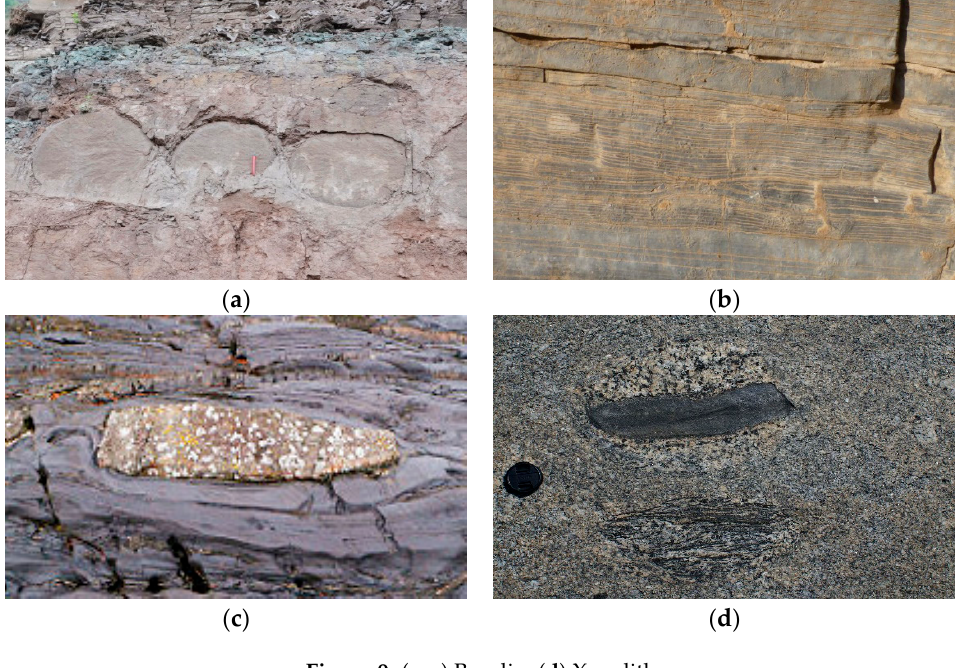
Figure 9. ( a – c ) Boudin; ( d ) Xenolith.